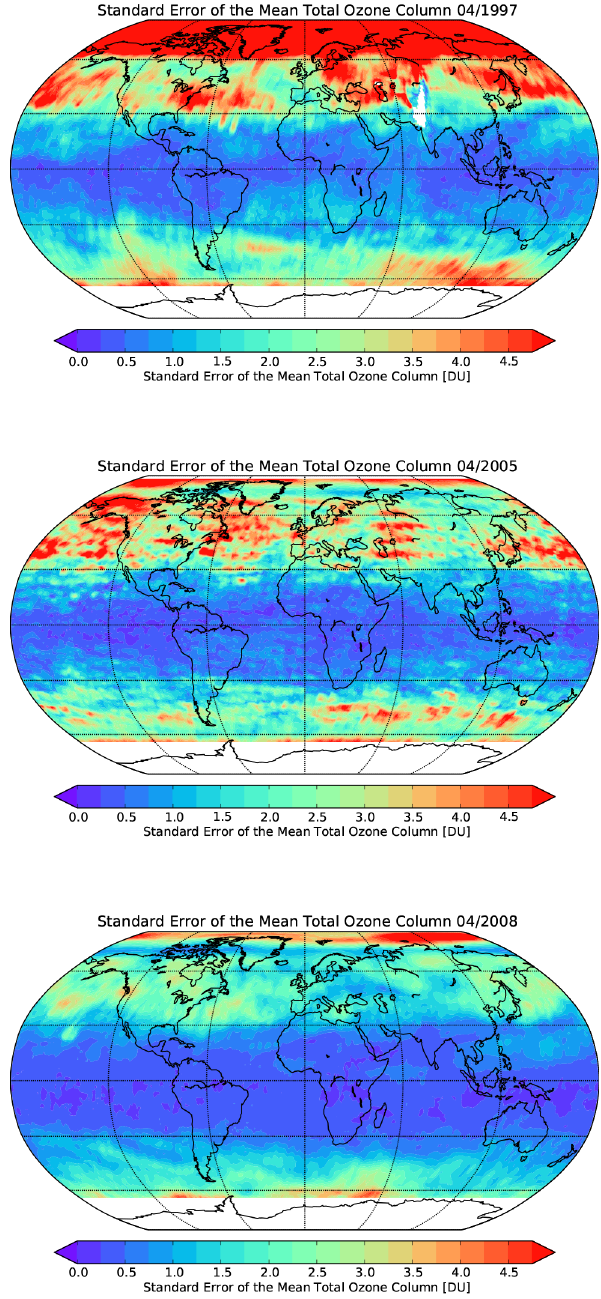
Figure 6. Standard error associated with the product for GOME (top), SCIAMACHY (middle), and GOME-2A (bottom) for April 1997, 2005, and 2008,